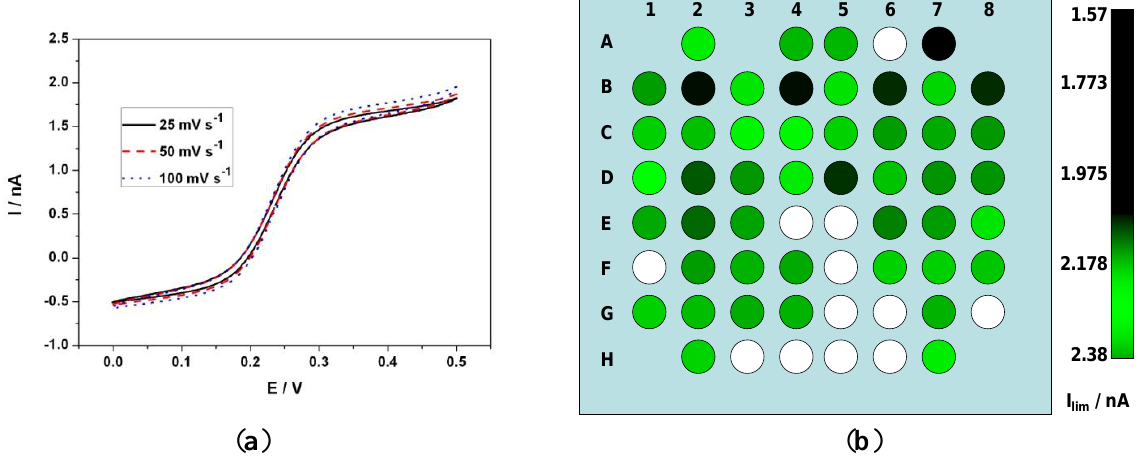
Figure 5. ( a ) Nyquist plot (experimental data and fitted data) of an ultramicroelectrode and ( b ) RGB model of an 8 × 8 electrode array where each electrode is represented by a circle and the blue component value corresponds to their respective k